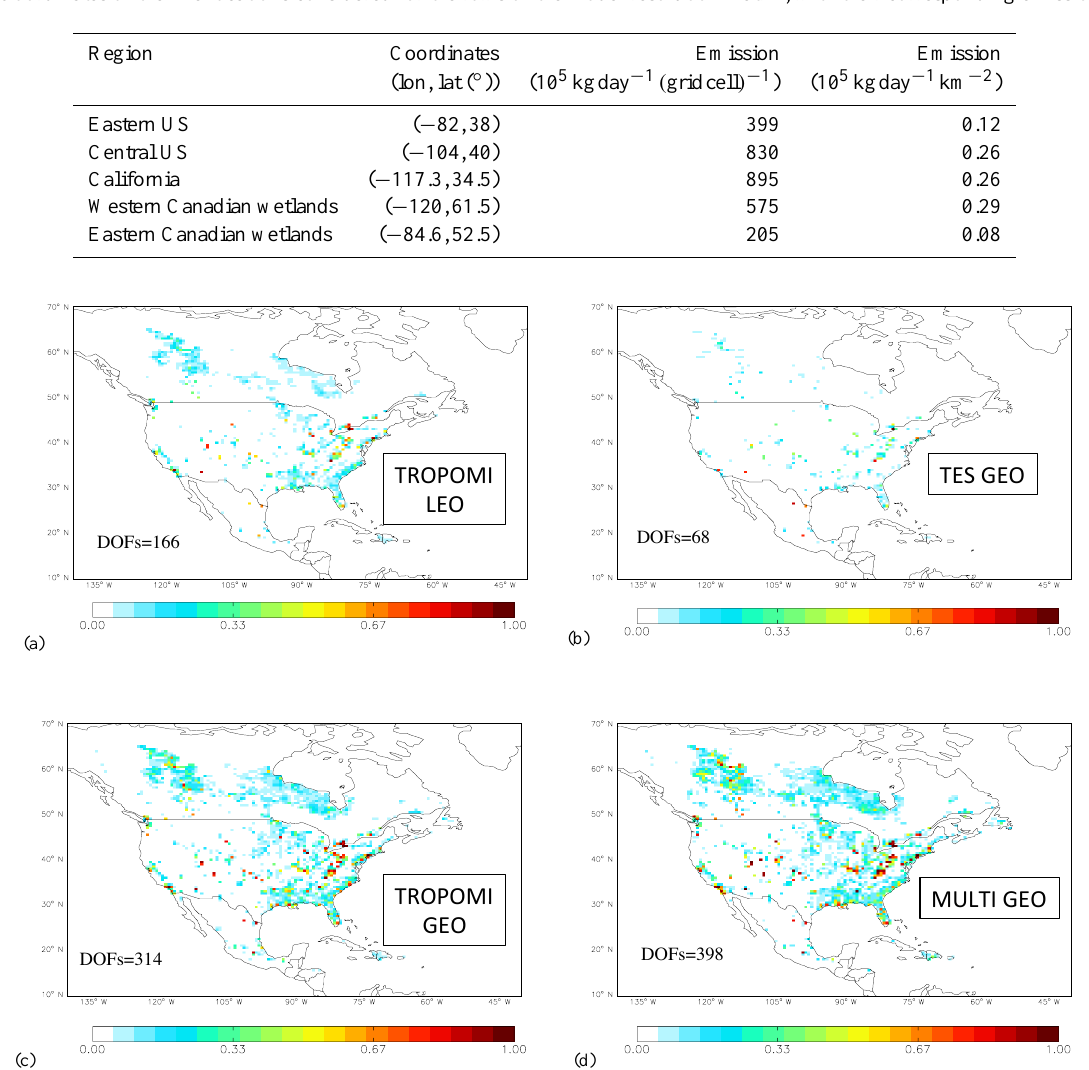
Figure 5. Relative error variance reduction for a 7-day methane emission optimization (1–8 July 2008) using (a) TROPOMI low-Earth orbit observations (TROPOMI_LEO); (b) GEO-CAPE observations with a TES-like instrument (TES_GEO); (c) GEO-CAPE observations with a TROPOMI-like instrument (TROPOMI_GEO); and (d) GEO-CAPE observations with a multi-spectral instrument (MULTI_GEO). Zero values correspond to emissions with no constraints from observations, while values of one correspond to emissions entirely constrained by observations. The DOF for each inversion, which is the sum of all diagonal elements of the model resolution matrix, is also